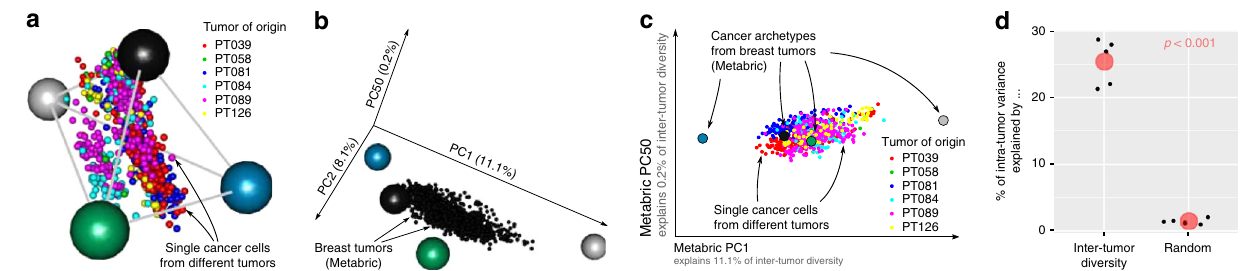
Fig. 4 Cancer tasks partly explain intratumor heterogeneity. a Projecting single-cancer cells from different breast tumors onto the tetrahedron de fi ned by metabric breast tumors shows that single-cancer cells from the same tumor can be generalists and specialists at different tasks. b Intertumor diversity varies mainly along the fi rst two principal components (PC) of the metabric tumors: the fi rst two PC explain 11.1 and 8.1% of the variance in gene expression between tumors whereas PC50 explains only 0.2% tumors thus fall on a plane within the volume de fi ned by PC1, PC2, and PC50. c Projecting single cancer cells from different breast tumors onto PCs from metabric tumors shows that intratumor heterogeneity is aligned with intertumor diversity. d Intertumor diversity explains a signi fi cant fraction of intratumor variance. PCs computed on metabric tumors explain 25.4% of the variance explained by PCs computed on single cells. PCs computed on a shuf fl ed version of the metabric data explain only 1.5% of the variance explained by single-cell PCs. Black dots represent different tumors. P -value from the T test. Data: gene expression in Metabric tumors from Curtis et al. 5 , single-cell gene expression in six breast tumors from Karaayva et al. tune gene expression towards some tasks and away from others.